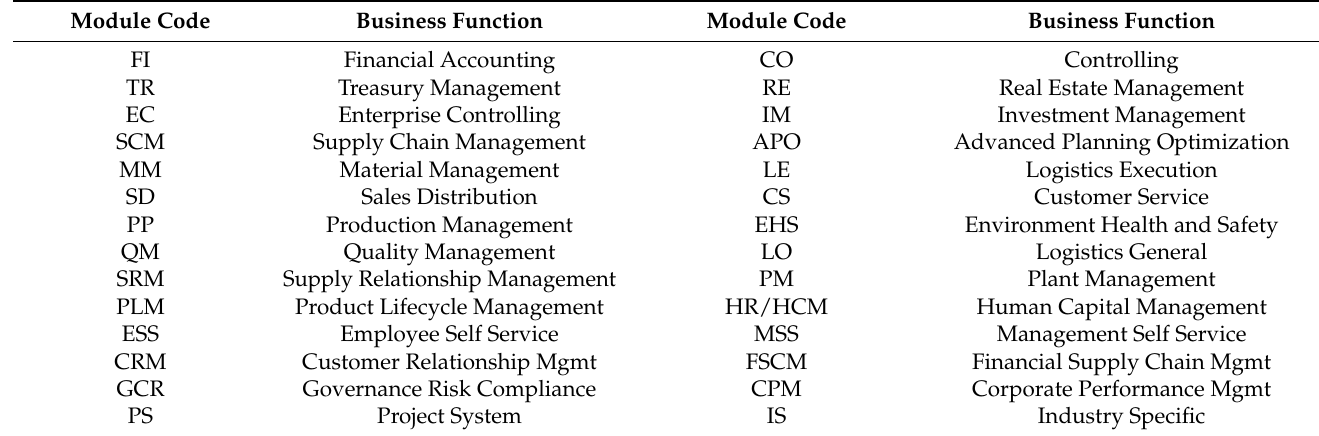
Table 1. SAP Functional Modules 1